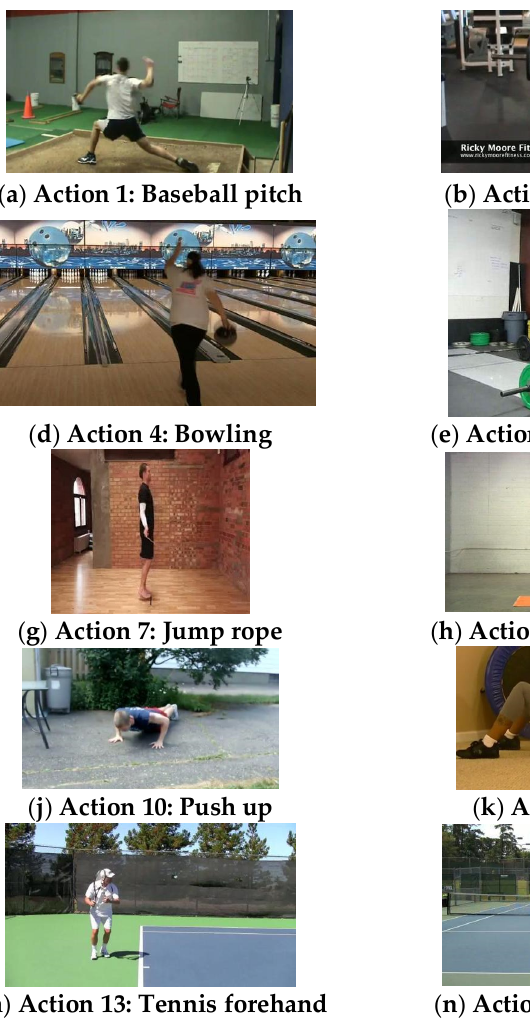
Figure 2. Sample video frames of each action from the Penn Action dataset. Table 3. The characteristics of the COCO and Penn Action